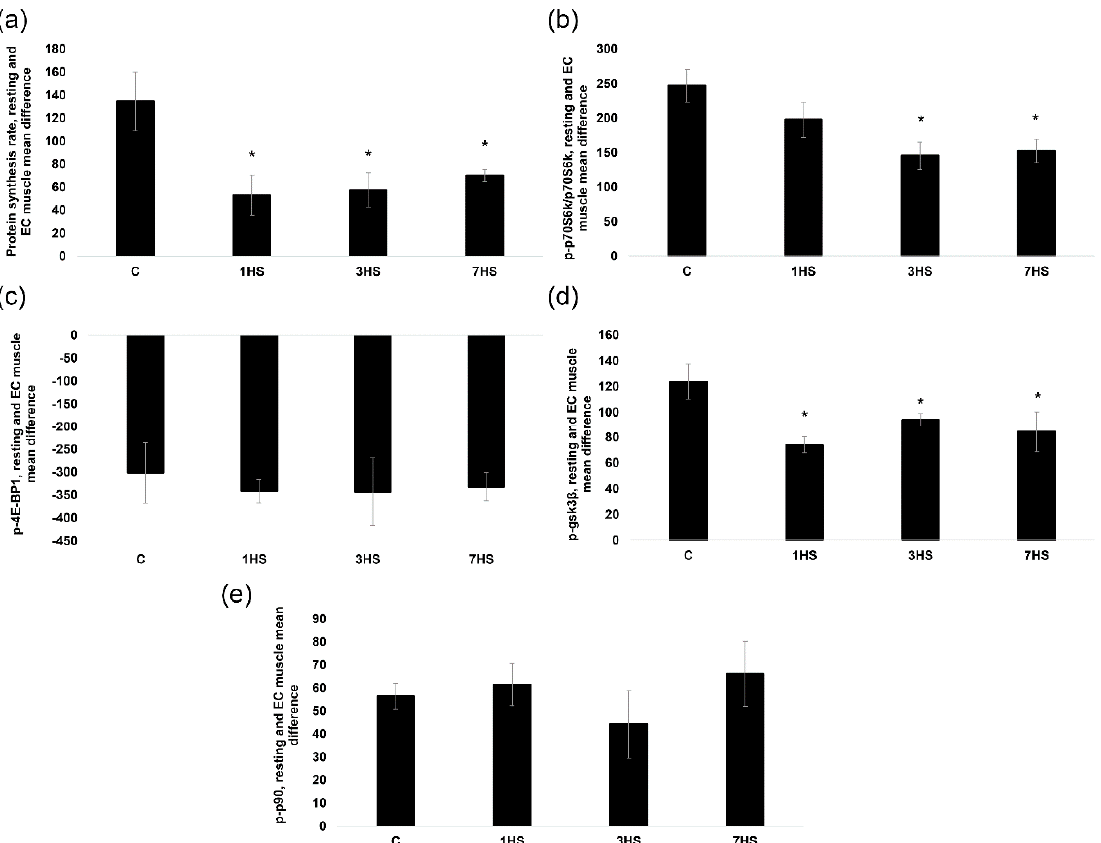
Figure 3. The mean difference in the rate of protein synthesis and phosphorylation of anabolic markers between resting and eccentrically-contracted muscles (experiment 1). ( a ): The rate of protein